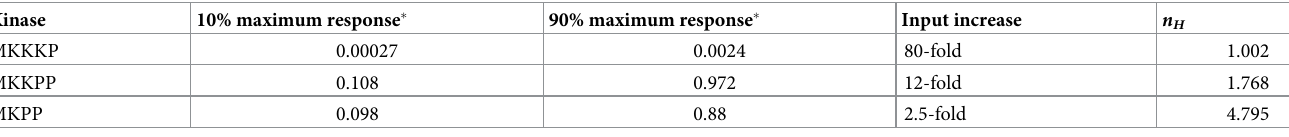
Table 1. Input differences in reaching from 10% to 90% of maximum concentration in kinases.